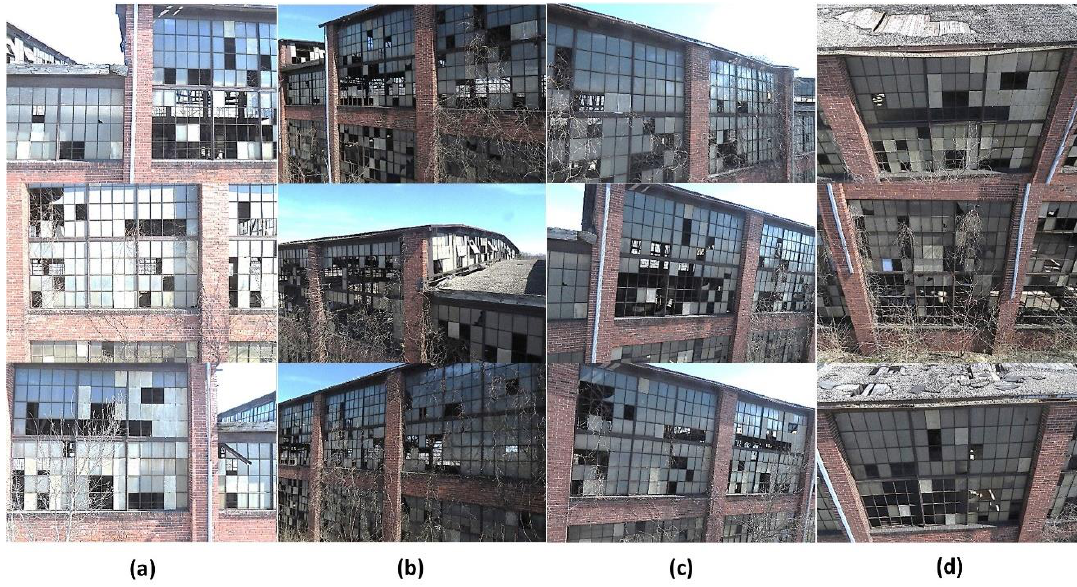
Figure 6. Sample images captured by UAVs from various angles: ( a ) Parallel, ( b ) left-angled, ( c ) right-angled, and ( d ) Downward.